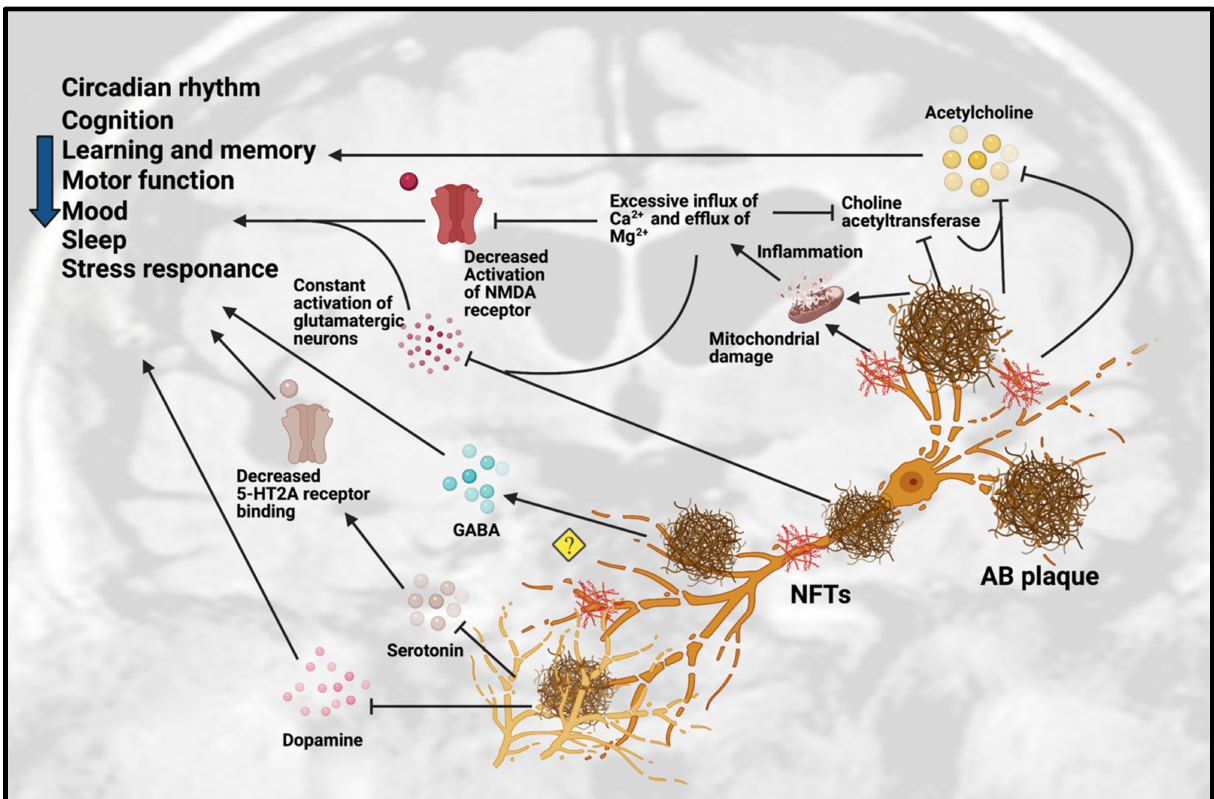
Figure 1. Dysfunction of neurotransmission in AD. Accumulation of A β plaques and NFT in AD cause impairment of the circadian rhythm, cognition, learning, memory, motor function, mood, sleep and stress response. These pathologies are toxic to neurotransmission systems, affecting cholinergic, glutamatergic, serotonergic and dopaminergic systems. Amyloid-beta plaques and NFT can inhibit the release of ACh and choline acetyltransferase, an enzyme that regulates ACh synthesis, which reinforces the inhibition effect of ACh. Amyloid-beta plaques and NFT can cause mitochondrial damage in glutamatergic neurons. The mitochondrial damage leads to inflammation due to excessive influx of Ca 2+ and excessive efflux of Mg 2+ that affect the activation of glutamatergic neurons and decreases the activation of NMDA receptor. The excessive influx of Ca 2+ in glutamatergic neurons leads to inhibition of choline acetyltransferase and further inhibits the synthesis of ACh. However, the detailed mechanisms are not yet understood, as some studies showed the upregulation of GABA in certain regions but downregulation of GABA in other regions. Amyloid-beta plaques also disrupt the homeostatsis of serotonin (5-HT) by inhibiting the binding of serotonin receptor (5-HT2A) and disrupting the dopaminergic system. Abbreviations: A β , Amyloid-beta; NFT, neurofibrillary